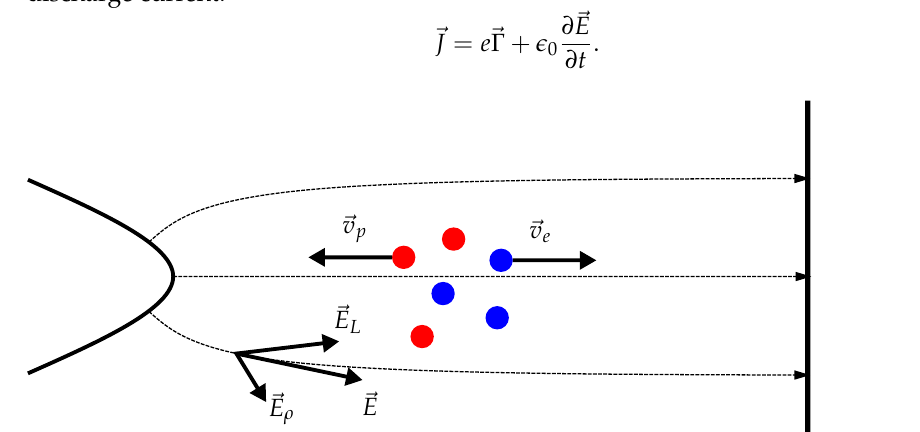
Figure 5. Schematic representation of the electric fields and the velocities of the charged particles based on